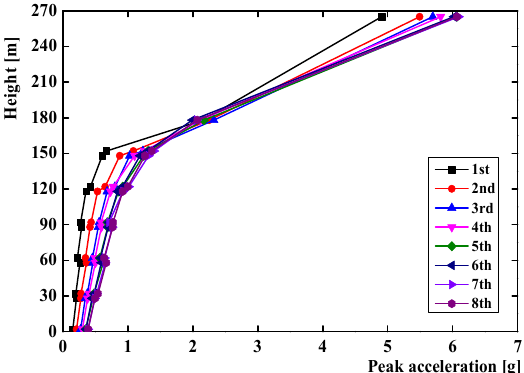
Figure 6. Peak acceleration of each measuring point.